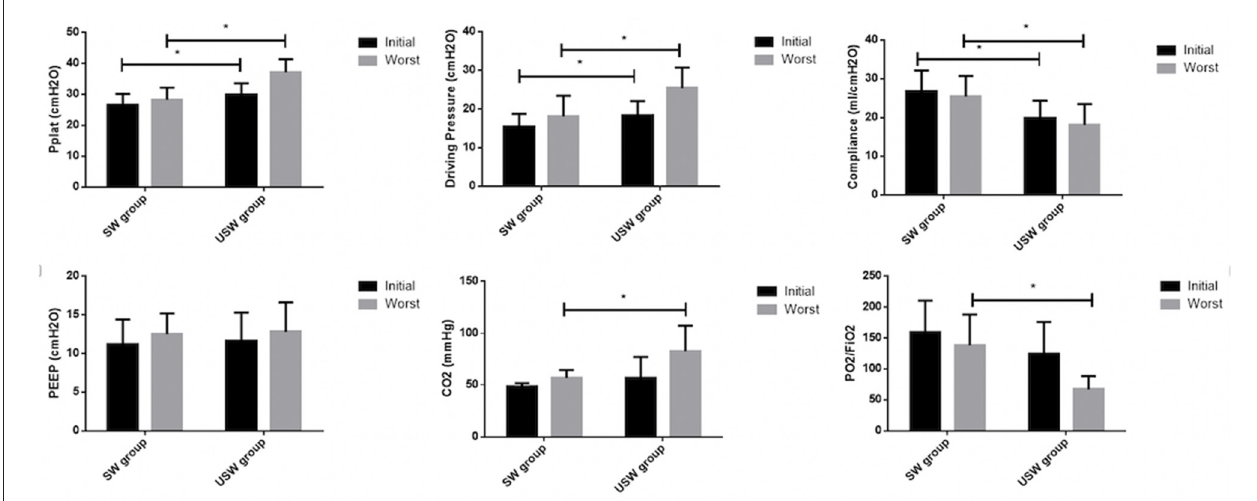
FIGURE 2 | The mechanical ventilation parameter comparison between successful weaning (SW) and unsuccessful weaning (USW). Initial, the first day of intubation or admittance to the intensive care unit (ICU); Worst, the worst in the observation days; PEEP, positive end-expiratory pressure; Pplat, plateau pressure; PCO 2 , partial pressure of carbon dioxide; PaO 2 /FiO 2 , the ratio of partial pressure arterial oxygen and fraction of inspired oxygen. *means the p -value < 0.05 between two groups.